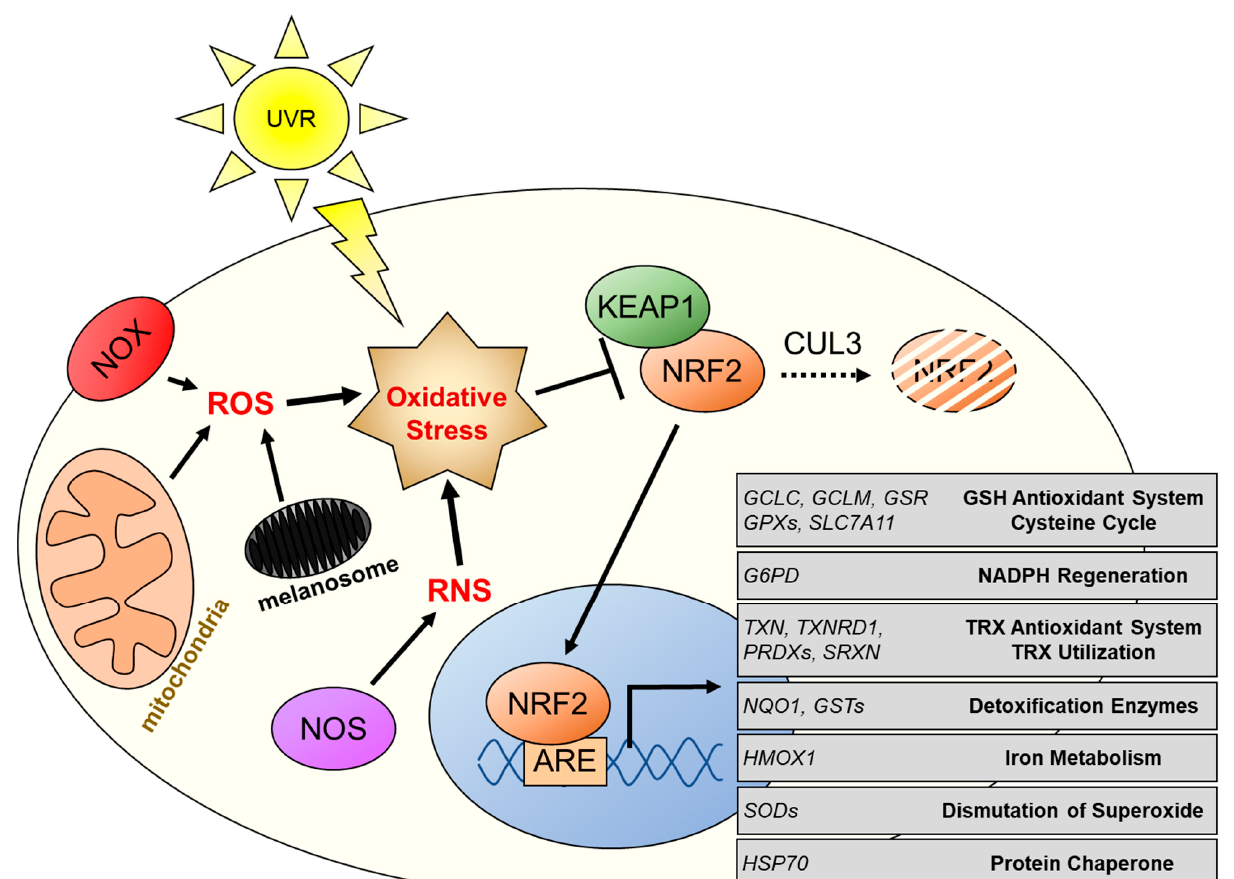
Figure 2. Sources of oxidative stress in melanocytes and subsequent activation of the NRF2/KEAP1/ARE-signaling pathway. Endogenous sources of oxidative stress include ROS pro- duced by mitochondrial respiration, melanosomal melanogenesis, and the activity of NOX enzymes as well as RNS produced by NOS enzymes. It should be noted that NOX enzymes are expressed in several subcellular compartments in addition to the plasma membrane, as depicted here. Exogenous sources of oxidative stress include environmental stressors such as UVR and exposure of the skin to pro-oxidant chemical substances. Under normal conditions, there is a consistent low level of NRF2 present that is sequestered in the cytosol by KEAP1. CUL3 can then bind to the NRF2/KEAP1 complex leading to the ubiquitination and subsequent degradation of NRF2. However, under condi- tions of oxidative stress, there are redox-sensitive cysteine residues on KEAP1 that become modified leading to the release of NRF2. Released NRF2 can then enter the nucleus, bind to AREs, and promote the expression of antioxidant genes. ARE, antioxidant response element; CUL3, E3 ubiquitin ligase cullin-3; GSH, glutathione; KEAP1, kelch-like ECH-associated protein 1; NOS, nitric oxide synthase; NOX, NADPH oxidase; NRF2, nuclear factor erythroid 2-like 2; RNS, reactive nitrogen species; ROS, reactive oxygen species; TRX, thioredoxin; and UVR, ultraviolet radiation. In the event of elevated oxidative stress, sensor cysteine residues located in the KEAP1 kelch domains act as a redox switch, which is flipped upon modification by oxidants. In this event, NRF2 is disassociated from the KEAP-CUL3 complex and accumulates in the cytosol [73]. It is then able to localize into the nucleus where it heterodimerizes with sMAF transcriptional co-factors and binds to genomic antioxidant response elements (AREs) [65]. NRF2 binding of ARE sequences located in the promoter regions of target genes leads to induced expression